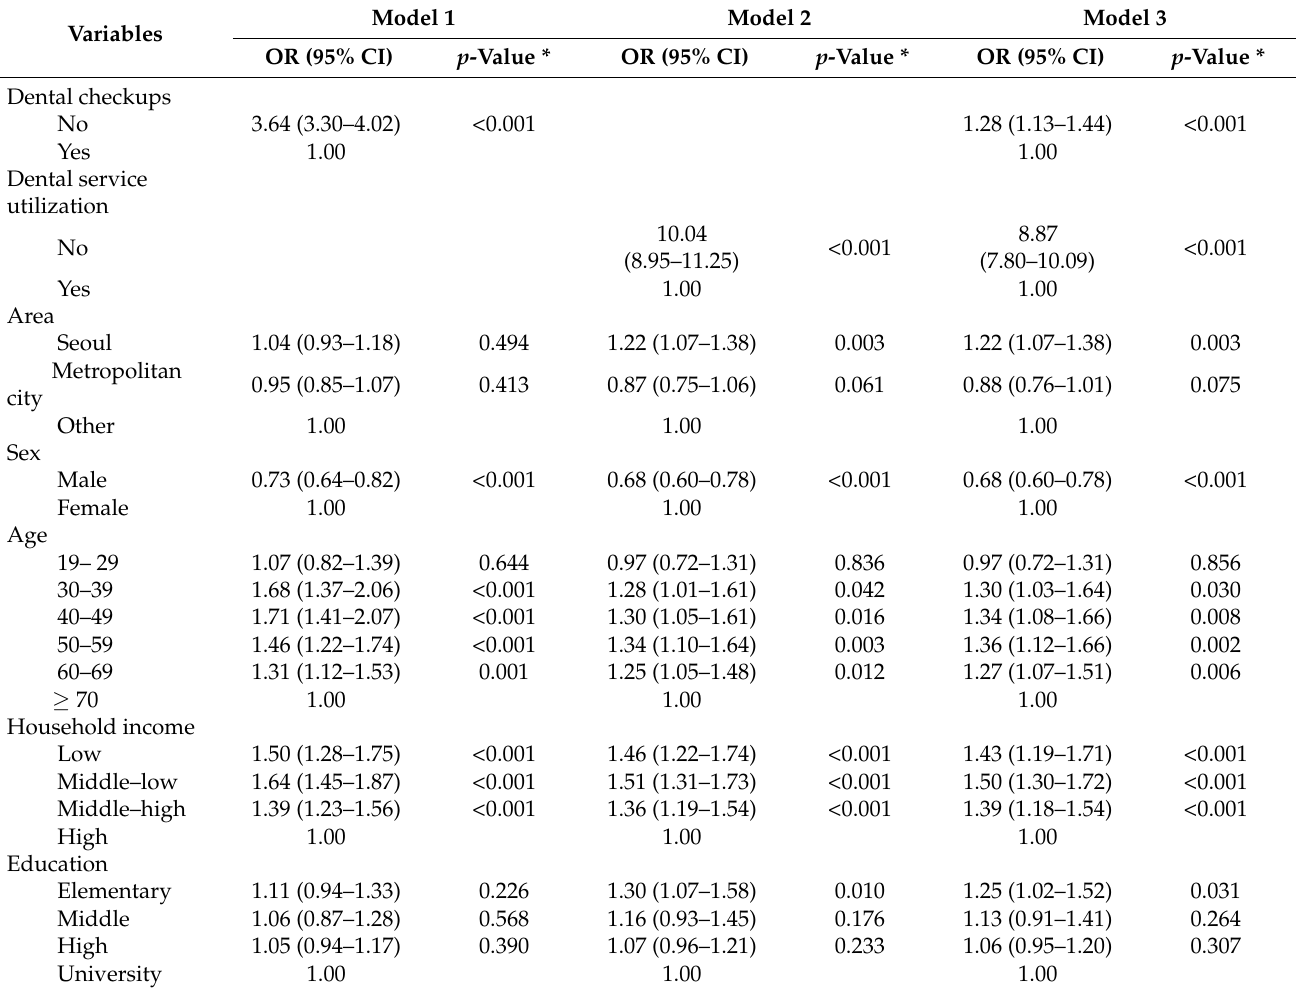
Table 2. Factors affecting unmet dental care